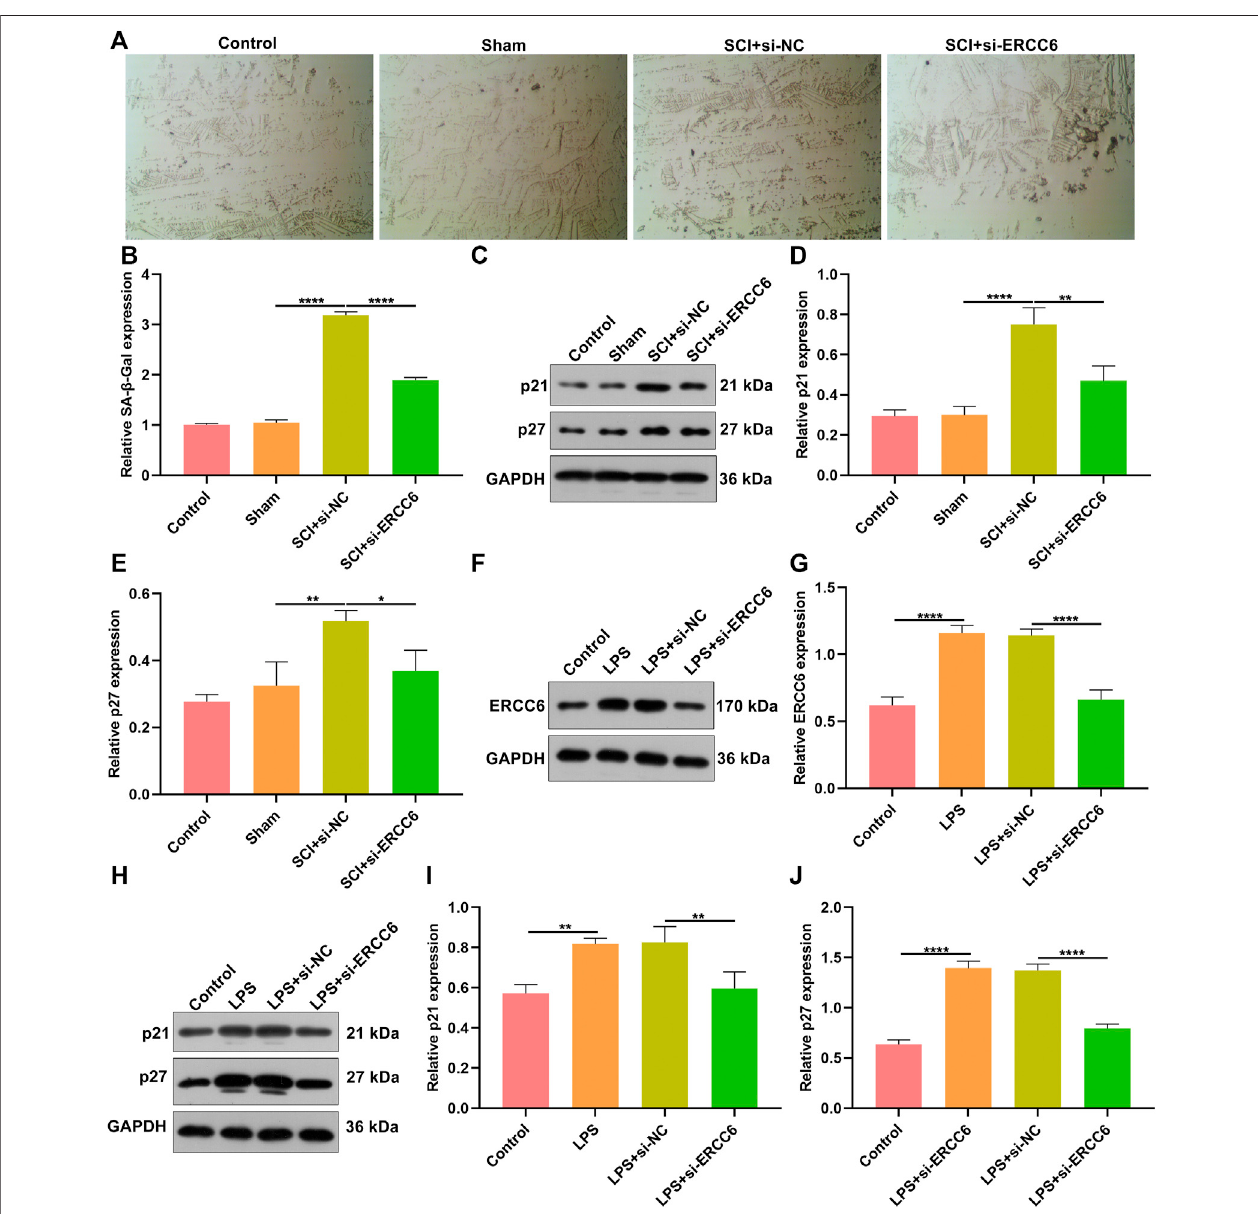
blottingforsenescent markersp21aswellasp27inthespinalcord tissuesofSCImiceinjectedwithsi-ERCC6 orsi-NCaswellascontrolandshamoperationmice(N= 8miceineachgroup). (F,G)